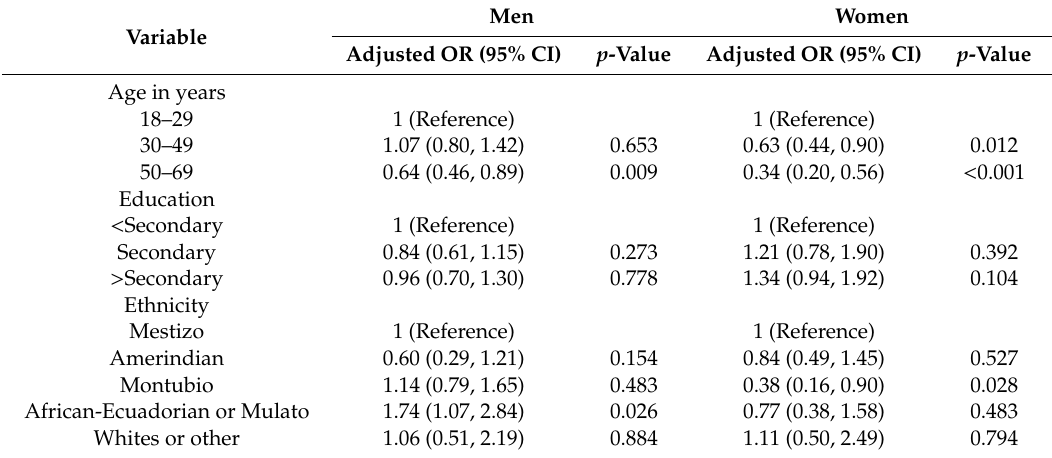
Table 4. Multivariable logistic regression with heavy episodic alcohol consumption stratified by